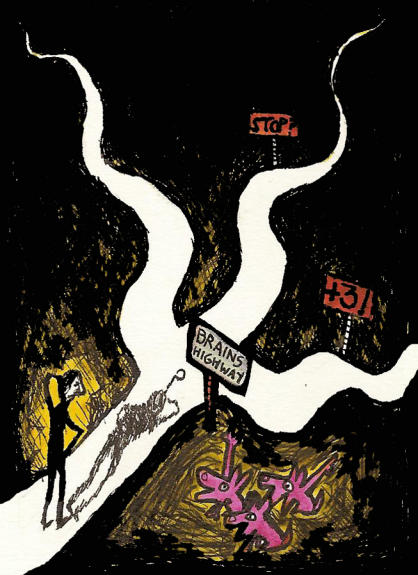
When faced with a decision to perform multiple, competing tasks, neural processes put constraints on which task to perform first and how quickly to do it.